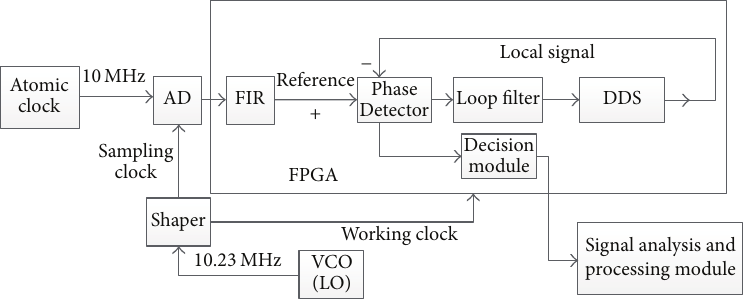
Figure 2: Schematic diagram of Self-Monitoring Method based on